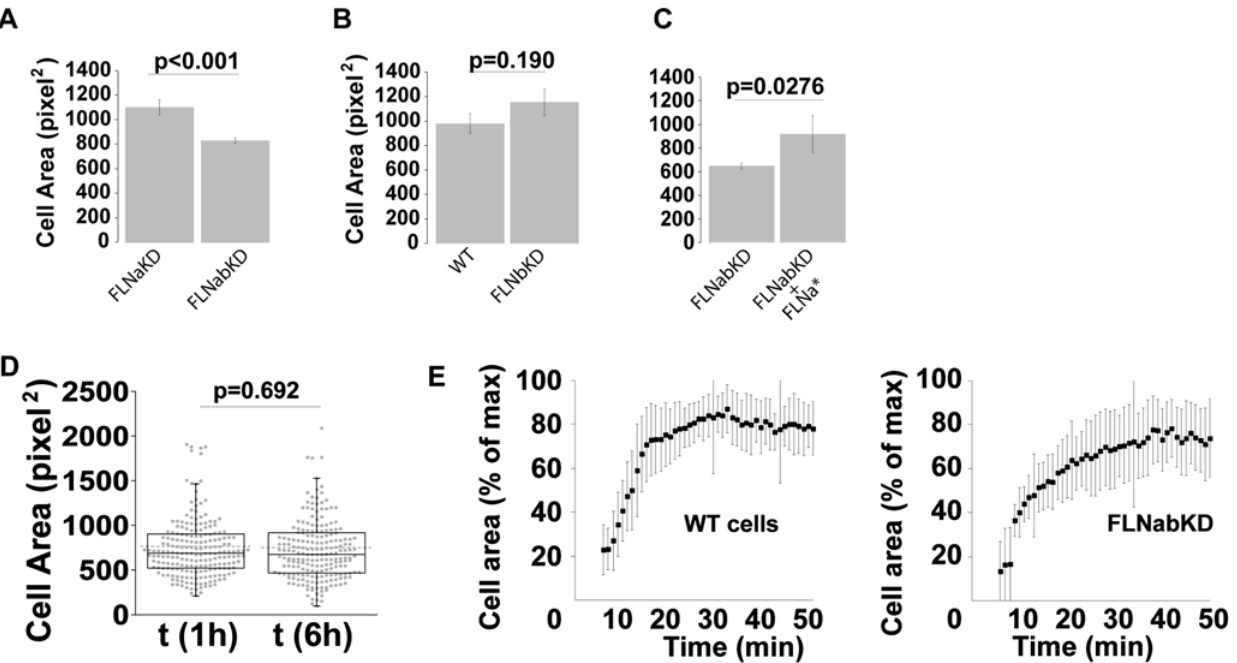
Figure 4. FLNabKD cells exhibit spreading defects. A,B ) FLNaKD and FLNabKD (A) or HT1080 WT and FLNbKD (B) cells were mixed and plated on FN-coated plates. After 6 hours cells were fixed and stained with anti-FLNb to discriminate between the two populations. The area was measured by manually rendering the cell contour in the phase contrast. (Sample size: FLNaKD=85; FLNabKD=89 from 5 experiments; WT=76; FLNbKD=59 from 3 independent experiments) 1 pixel 2 =1.664 m m 2 . Error bars show SEM. C ) FLNabKD cells were transfected with FLNa*-GFP. 24 hours later cells were detached, replated and allowed to adhere and spread as described in A and B. After fixation cells were stained with anti-FLNa to identify FLNa* expressing cells (sample size: $ 10 from 6 independent experiments). 1 pixel 2 =1.664 m m 2 . Error bars show SEM. D ) Comparison of cell area at the start and end of time-lapse recording. 1 pixel 2 =1.664 m m 2 . Dot plot shows the overall population distribution (sample size=213; from 10 independent experiments) dotted line shows the mean value, box and whiskers plots show quartiles. P values were calculated using a paired t-test. E